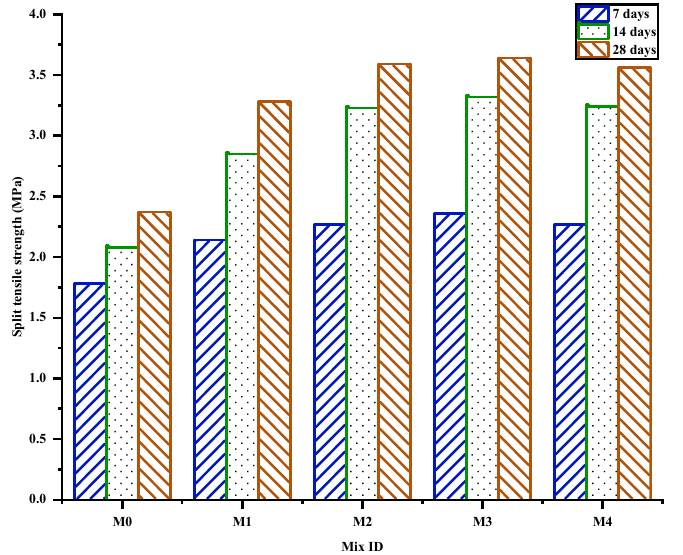
Figure 3. Split tensile strength of fine-grained cementitious composites for five different mixes.